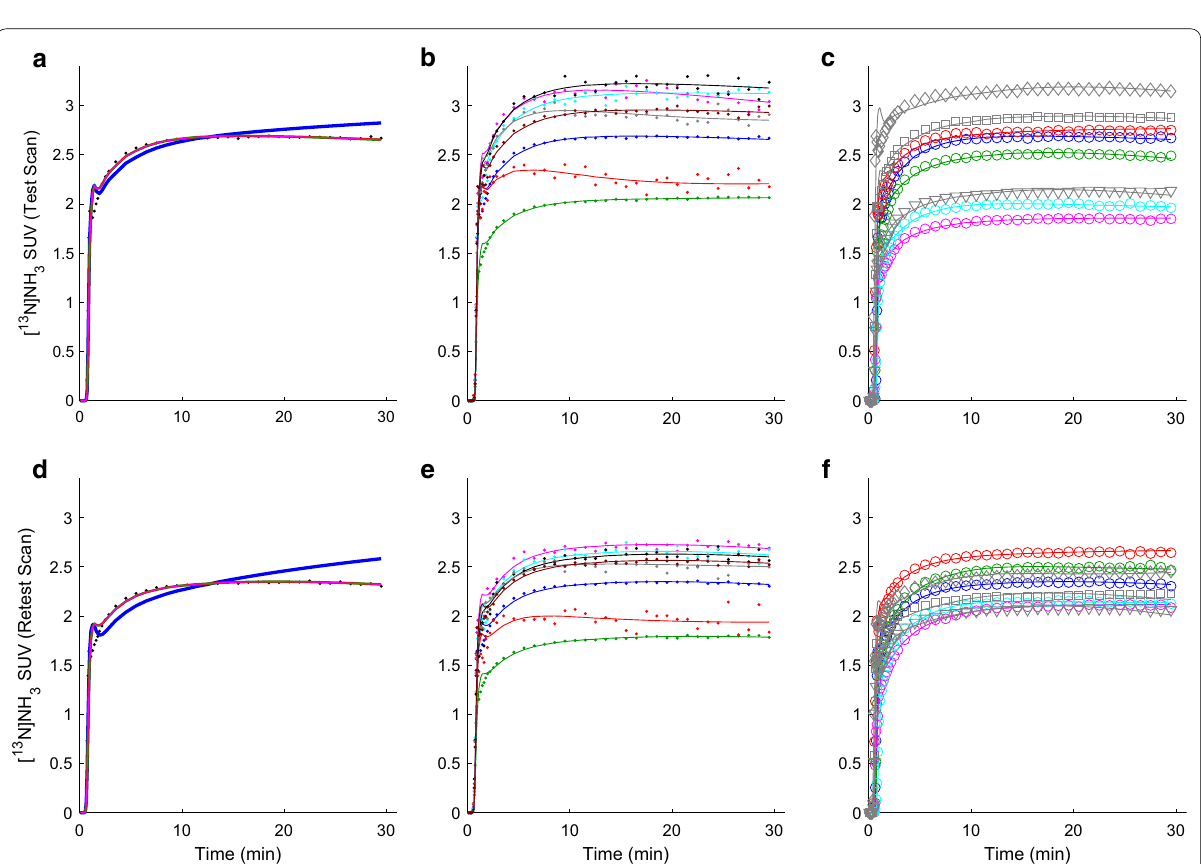
0 Fig. 2 Representative ammonia TAC data and fit examples. Symbols show example time activity curves (TACs) from ammonia PET scans and lines show model fits. Top row ( a – c ): data from test scan; bottom row ( d – f ) data from retest scan. 1st column ( a , d ): Subject 1, fits to grey matter TAC: blue line: irreversible 1TCM ( K 1 plus blood volume, V b ); green line: reversible 1TCM ( K 1 , k 2 , V b ); red line: irreversible 2TCM ( K 1 , k 2 , k 3 , V b ) and magenta line: reversible 2TCM ( K 1 , k 2 , k 3 , k 4 , V b ). The most complex three models appear to fit equally well and appear as superimposed on the graph. 2nd column ( b , e ): TAC (point) and irreversible 2TCM model fits (lines) from subject 1 for grey matter (blue), white matter (green), left hippocampus (red), left lingual gyrus (magenta), left posterior cingulate gyrus (cyan), left putamen (black), left thalamus (grey) and left cerebellum (dark red). c TACs (points) and irreversible 2TCM model fits (lines) for grey matter in all subjects. Coloured circles and lines (blue, green, red, magenta and cyan, for subjects 1–5, respectively) and grey symbols and lines (triangle/solid, square/dashed, diamond/dotted for subjects 6–8, respectively). All fits for all subjects are shown in Additional file 1: Figure